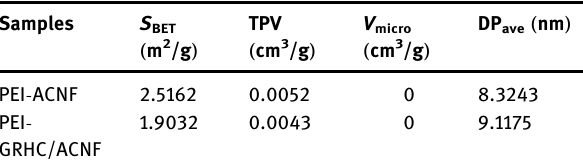
Table 4: Textural characteristics of PEI - impregnated ACNFs and